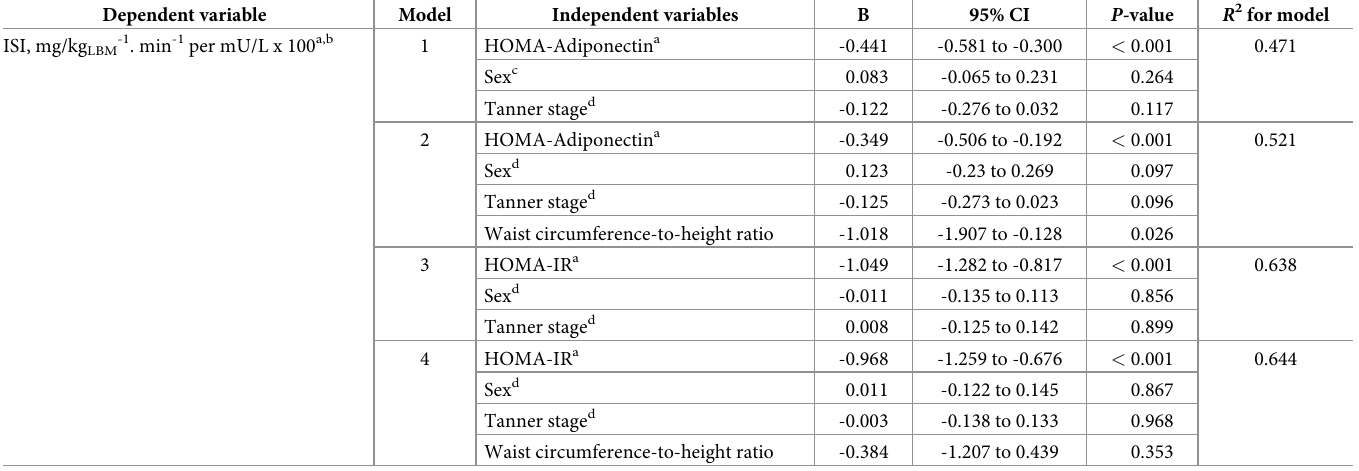
Table 2. Multiple regression analysis of the HOMA-Adiponectin and HOMA-IR with clamp-derived insulin sensitivity index.